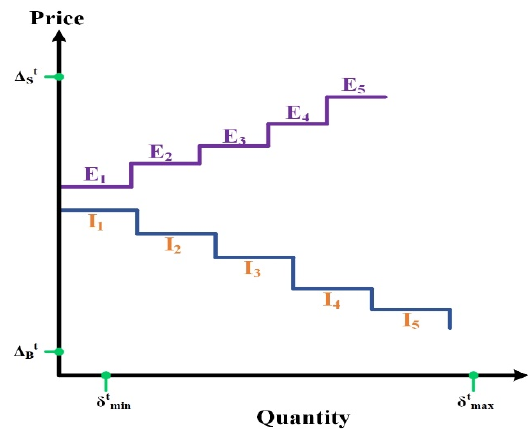
Figure 3. The DAS failure scenario.